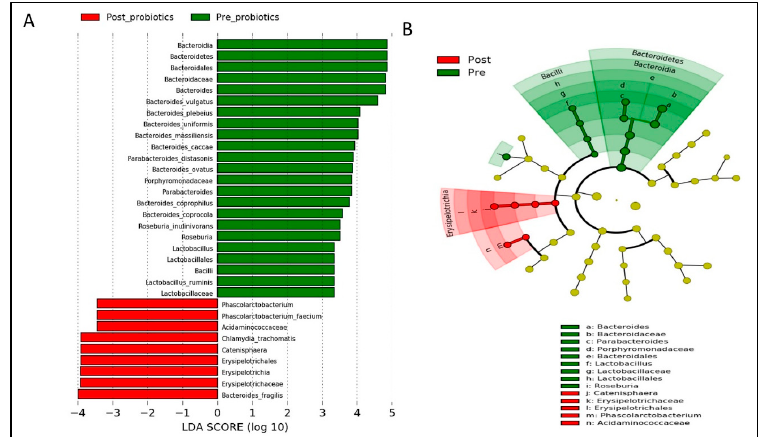
Figure 8. Linear discriminant analysis (LDA) effect size (LEfSe) analysis showing significantly abundant gut microbial taxa down to species level within the probiotics group. ( A ) Histogram represents the LDA scores for differentially abundant gut microbial taxa within the probiotics group, pre- and post-intervention. ( B ) Cladogram represents the taxonomic structure and relative abundance of the predominant gut microbial taxa within the probiotics group, pre- and post-intervention. The size of each dot in the cladogram represents the relative abundance of the identified gut microbial taxa. α < 0.05 and LDA score ≥ 2.0 were considered statistically significant.